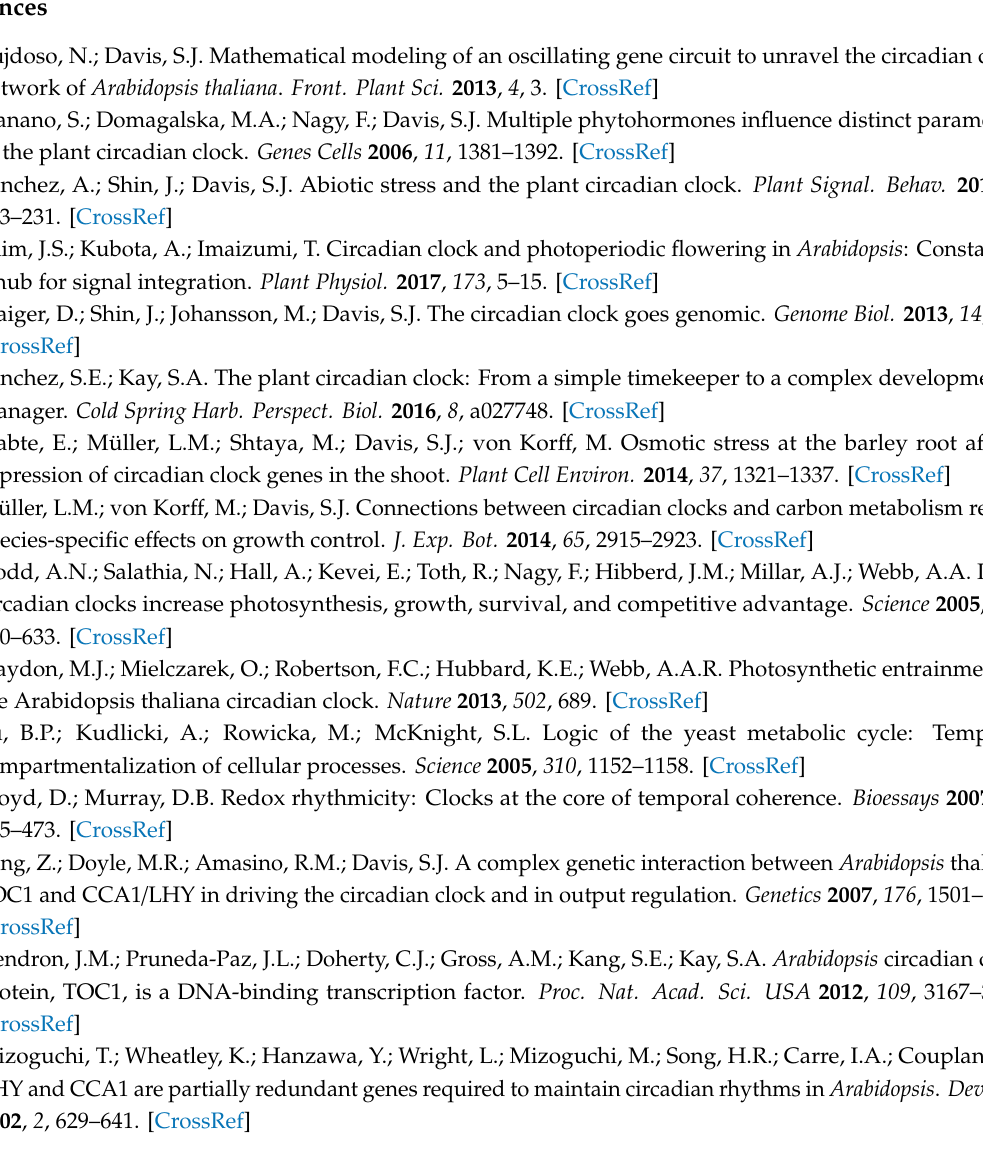
Figure S1: The e ff ect of sucrose on accuracy and periodicity of di ff erent luciferase markers in di ff erent ecotypes, Figure S2: Sucrose has a light specific e ff ect in the gi-11